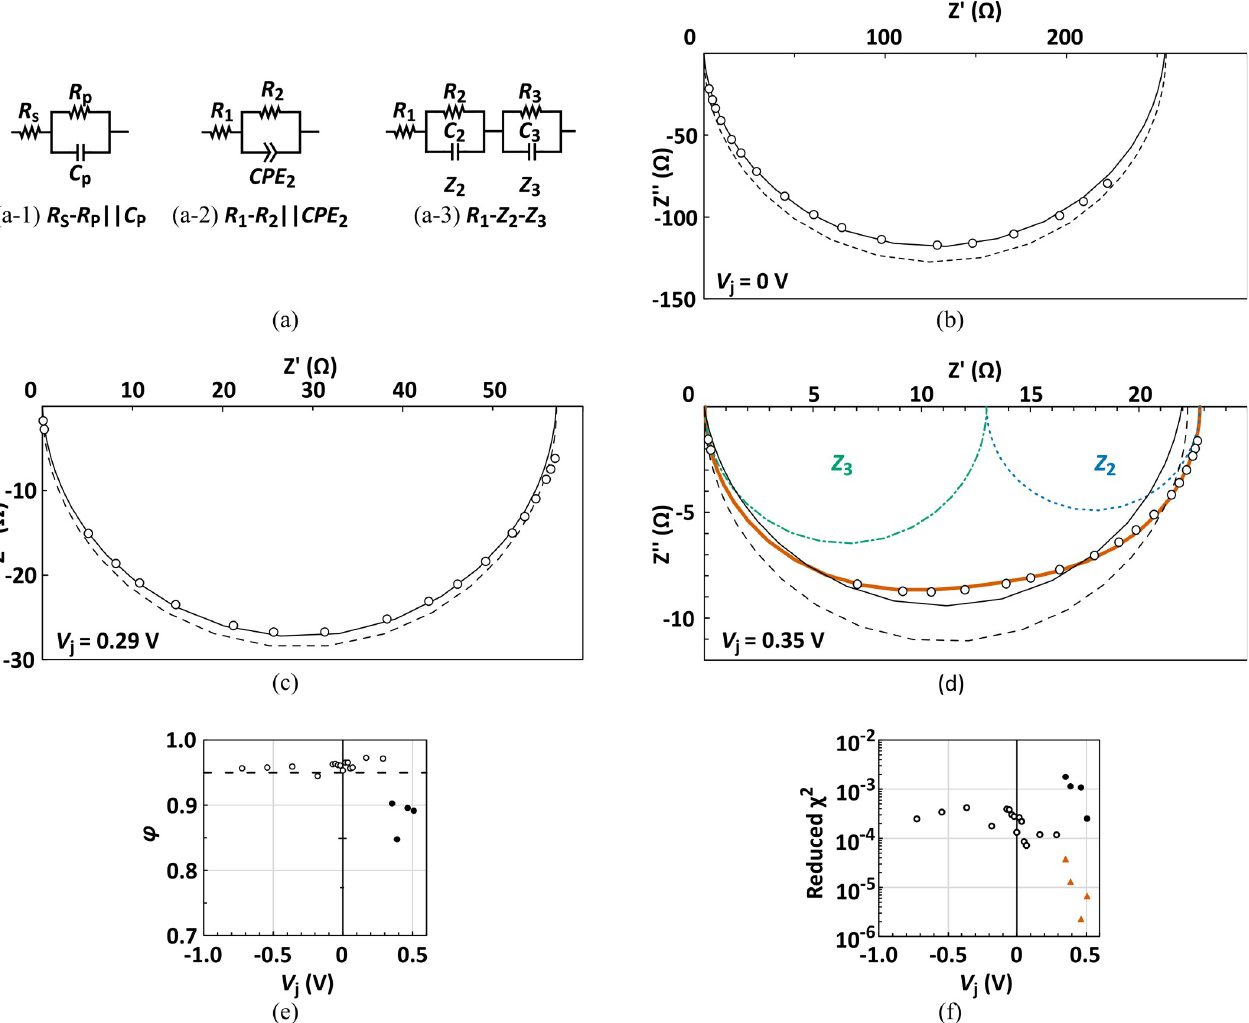
Fig 5. AC impedance characteristics of PV cells. (a) Postulated AC equivalent circuits for the R s - R p || C p model (a-1), R 1 - R 2 || CPE 2 model (a-2), and R 1 - Z 2 - Z 3 model (a-3). (b-d) The Nyquist plots for AC impedance (open circles) measured at various forward DC bias voltages for F08 cell. The dashed and solid curves in black color indicate the model curves based on the R s - R p || C p model (a-1) and R 1 - R 2 || CPE 2 model (a-2), respectively. In (d), the blue, green, and thick-orange curves denote the model curves derived from each component ( Z 2 , Z 3 ) and the entire R 1 - Z 2 - Z 3 model, respectively. In (e), the capacitor factor ( φ ) in the R 1 - R 2 || CPE 2 model (a-2) for the F08 cell is indicated as a function of V j . Each reduced χ 2 at various V j is plotted in (f). Reduced χ 2 from the R 1 - R 2 || CPE 2 model (a-2) is shown as the open circle when V j < 0.3 V, although those obtained at V j � 0.3 V are indicated as closed circles. Additionally, each reduced χ 2 from the R 1 - Z 2 - Z 3 model (a-3) is plotted as the orange